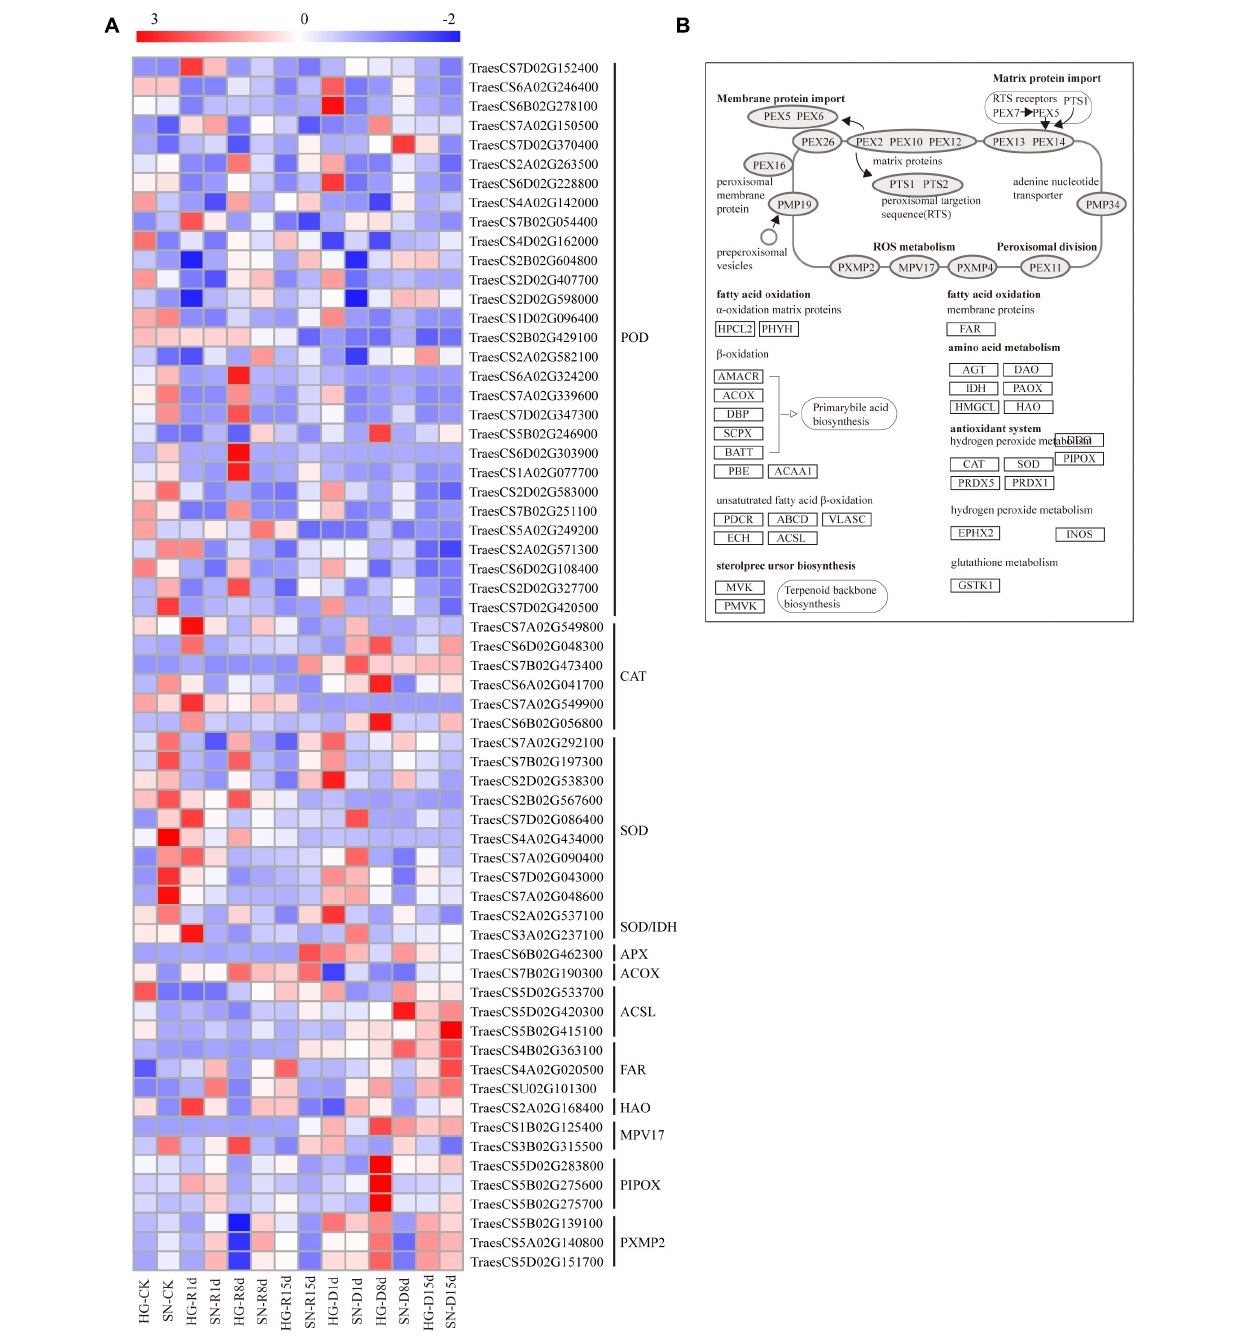
Frontiers in Plant Science |